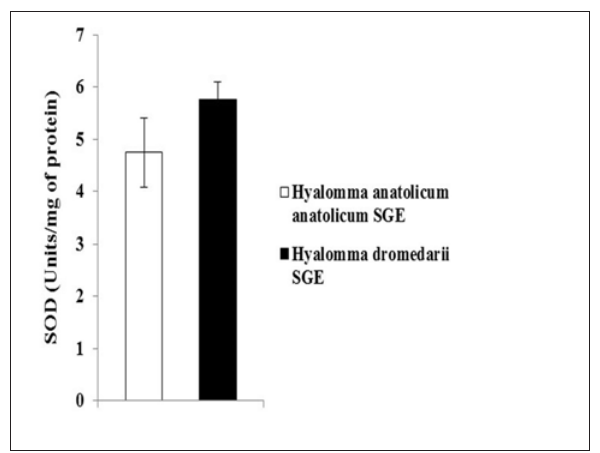
Figure-3: Superoxide dismutase activity (units/mg of protein) in salivary gland extracts of Hyalomma anatolicum anatolicum and Hyalomma dromedarii ticks. Data presented as mean±standard error; N=6 Groups, each group containing six ticks.